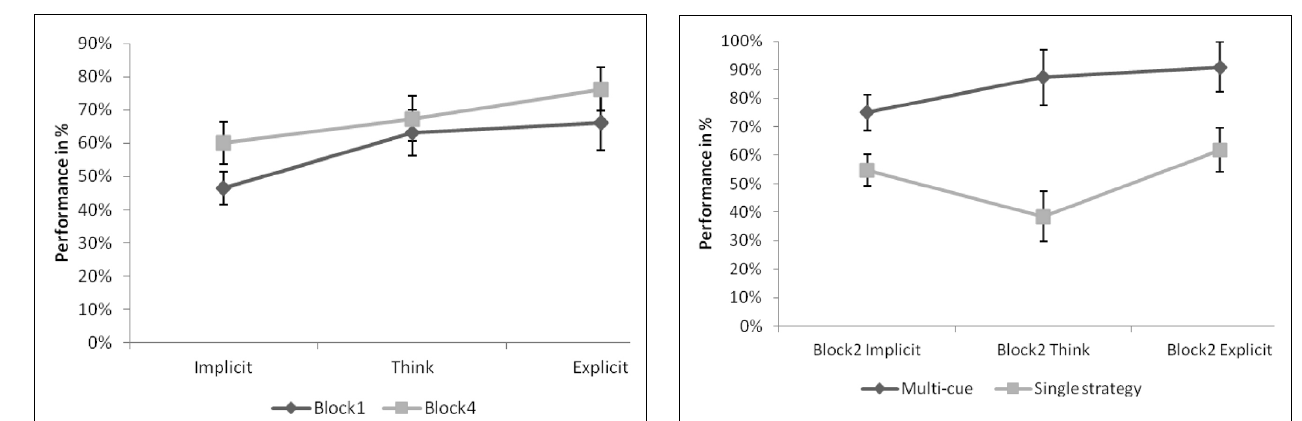
FIGURE 3 | Performance of the experimental group associated by answer-type in Block 1 and Block 4. Error bars indicate Standard Error.